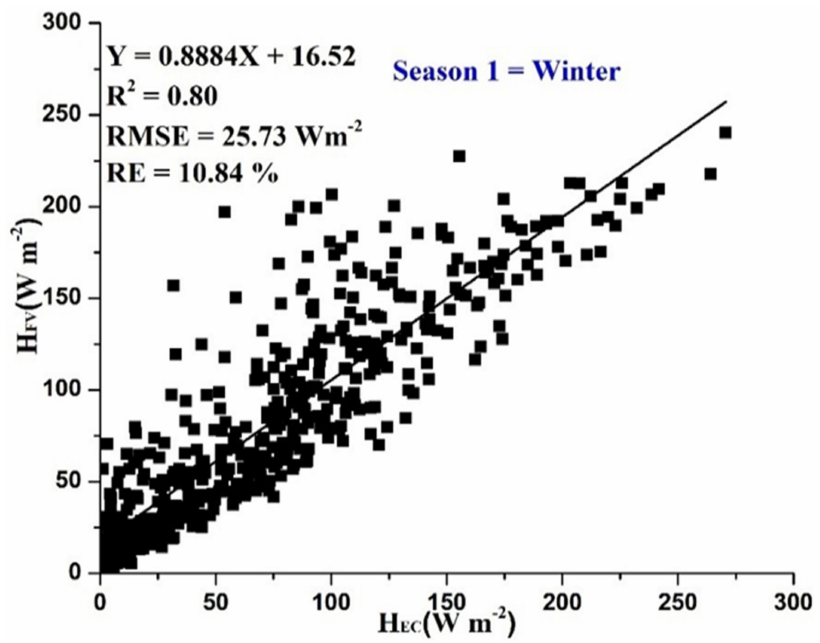
Figure 5. Regression analysis between the half-hourly dataset of H FV and H EC at the measurement height of 1.8 m for Season 1 (DOY 305–360,